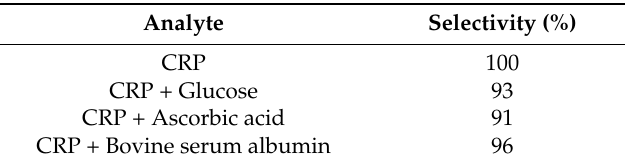
Table 2. Selectivity of the present CRP immunosensor strip.